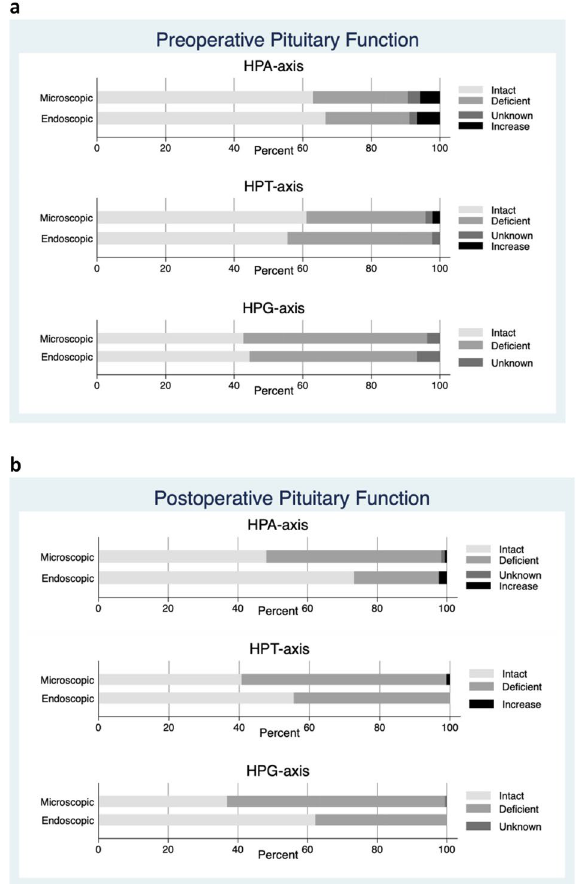
Figure 2. Preoperative ( a ) and postoperative ( b ) clinical biochemical data showing pituitary function in patients with pituitary adenomas undergoing either endoscopic or microscopic